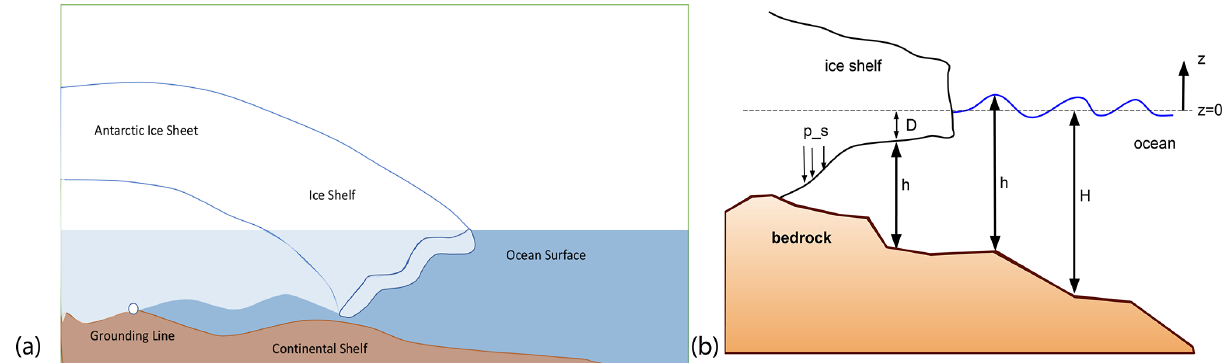
Figure 1. (a) Schematic of ice shelf cavity. The grounding line (between the ice shelf and continental shelf) is marked with a white circle (b) . Schematic showing the dynamic water thickness h , reference thickness H , ice draft D and surface pressure p s .